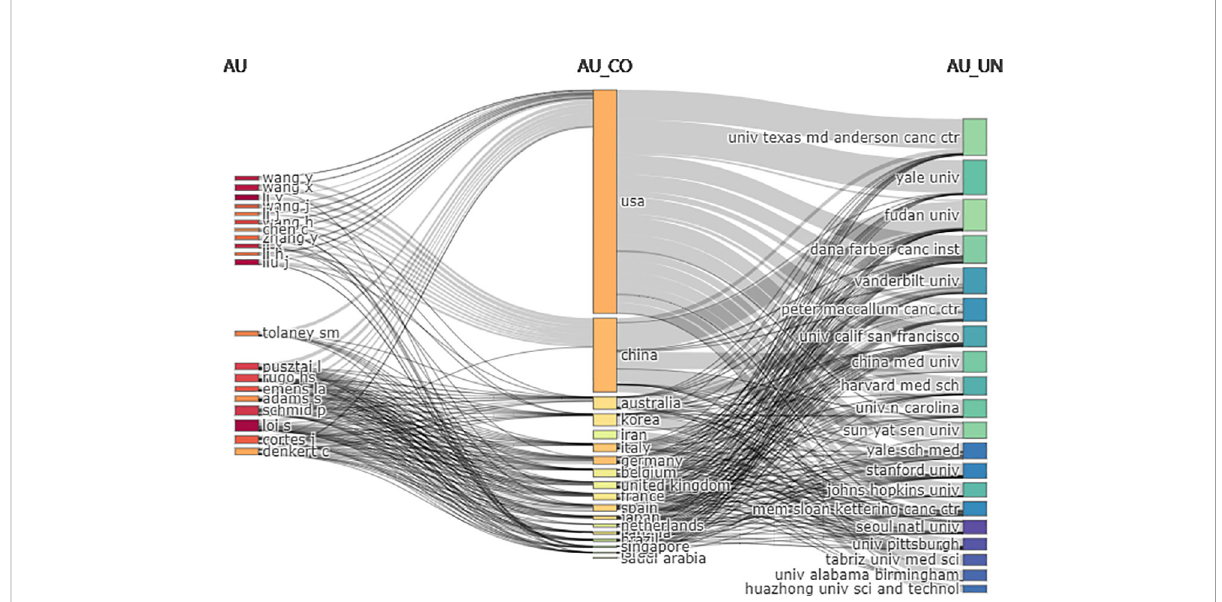
FIGURE 6 Three- fi eld plot among countries, authors, and af fi liations (Left fi eld: authors, middle fi eld: countries, right fi eld: af fi liations; number of items each column: